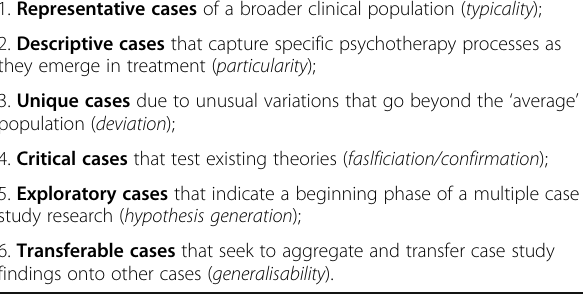
Table 12 Key concept: purpose – based systematic case